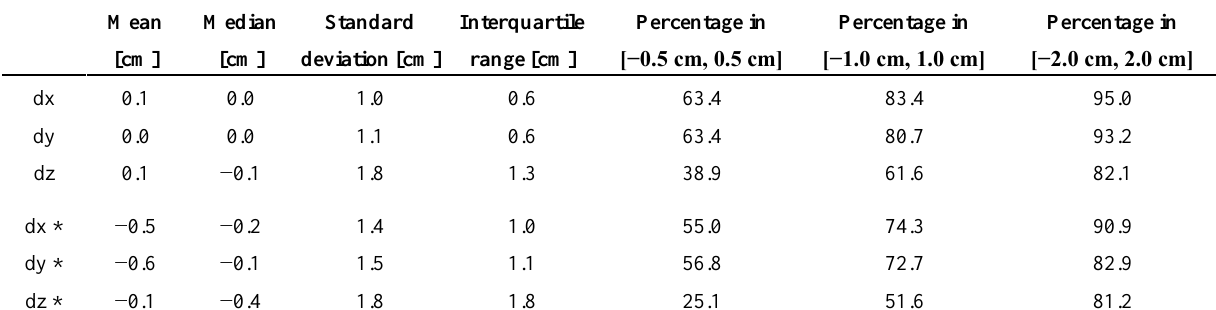
Table 4. Statistics of discrepancies between the closest point pairs. The last three rows show, for comparison, the same statistics obtained for an uncalibrated Kinect point cloud.